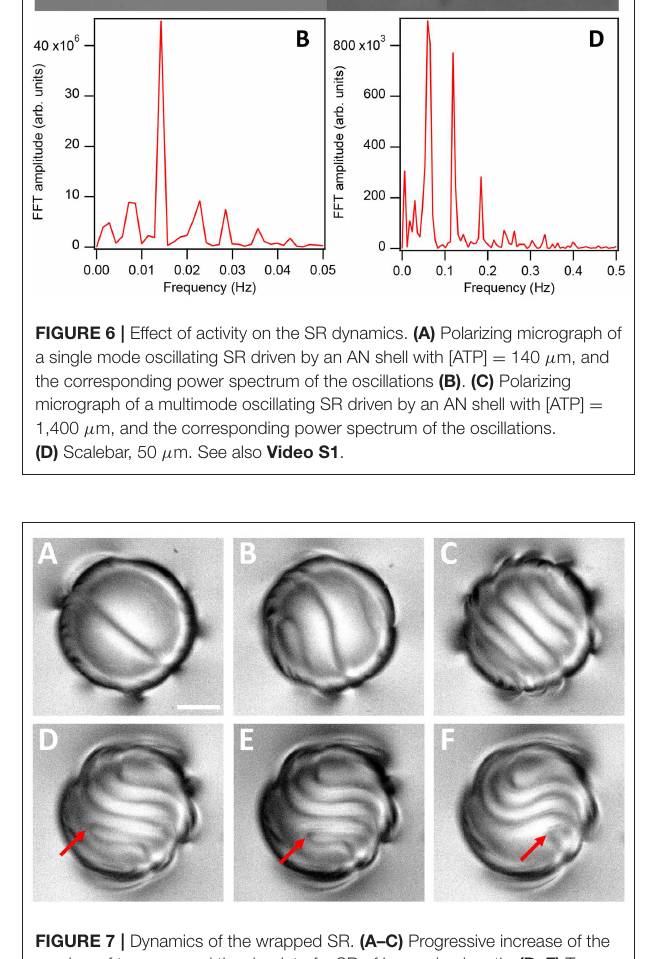
FIGURE 7 | Dynamics of the wrapped SR. (A–C) Progressive increase of the number of turns around the droplet of a SR of increasing length. (D–F) Two neighboring parts of the SR from ajdancent turns snap, and the resulting fold in the disclination shrinks. Red arrow points to the tip of the shrinking fold. Scalebar, 20 µ m. See also Video S2